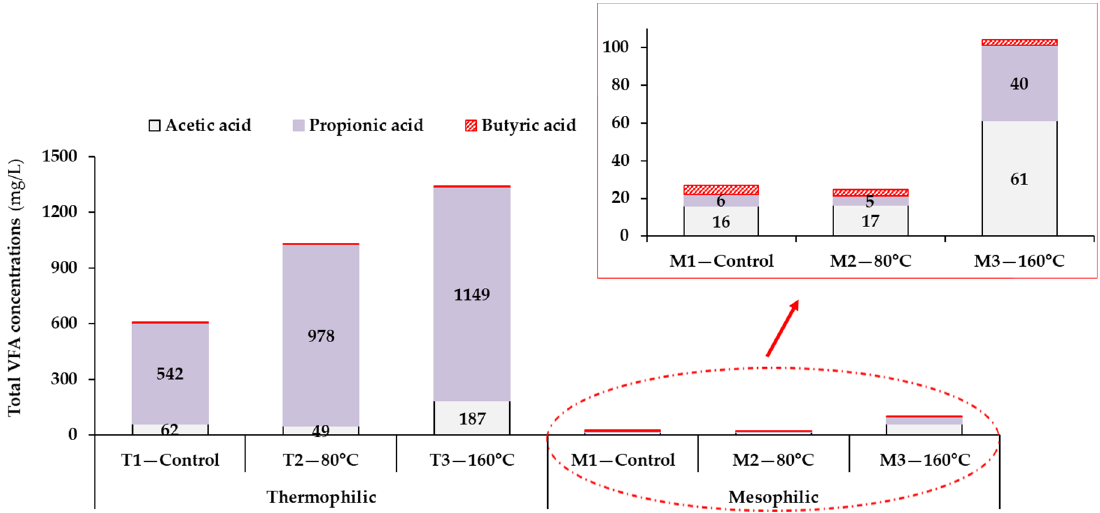
Figure 2. Concentrations of acetic, butyric, and propionic acids in the thermophilic and mesophilic digesters operated under high organic loading rates.